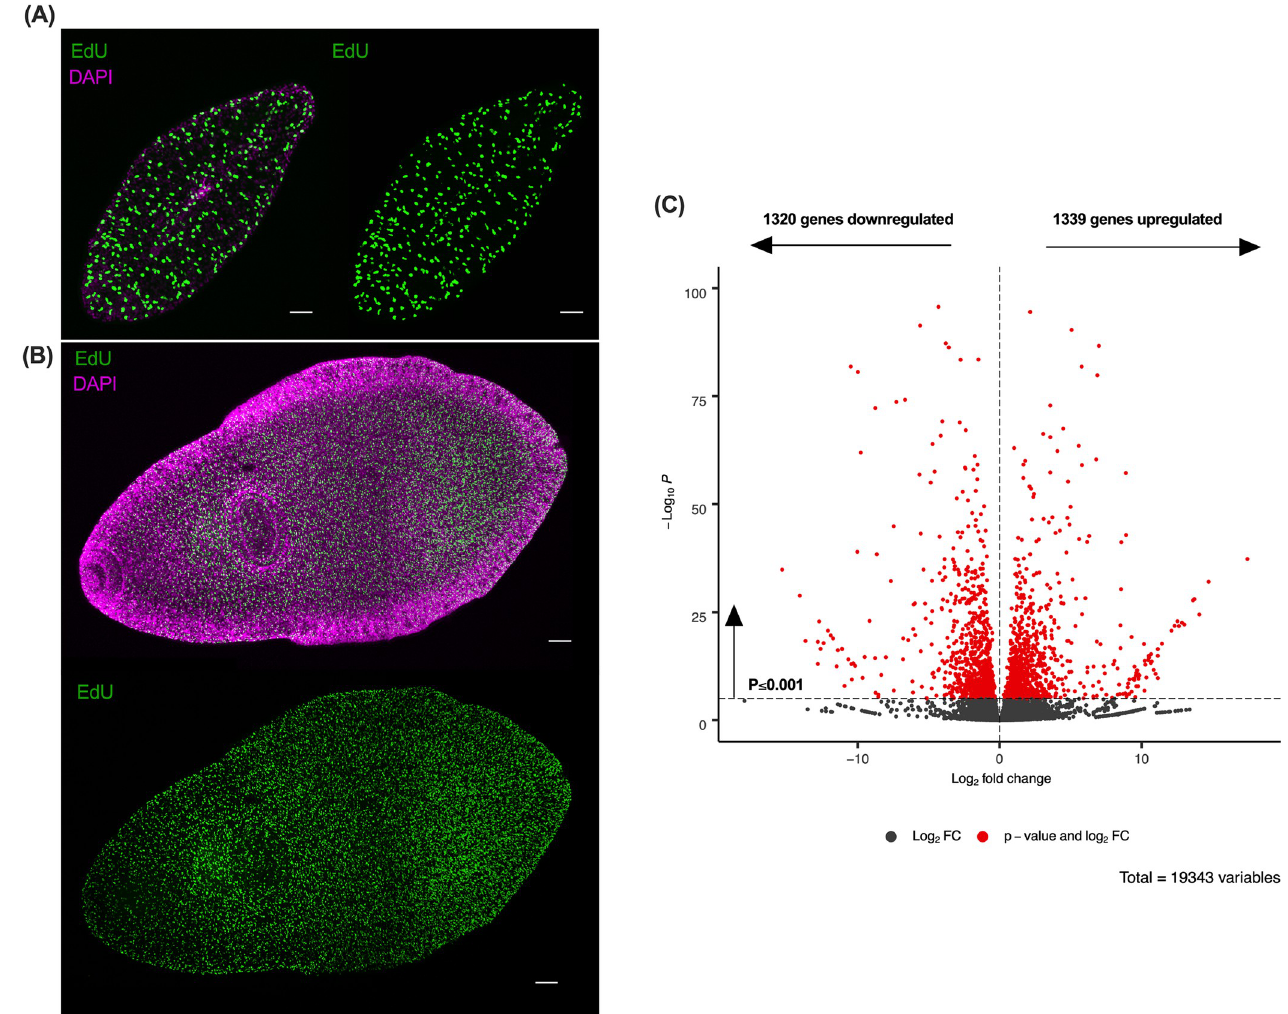
Fig 2. In vitro and in vivo maintained juvenile liver fluke display differences in growth and cell proliferation. (A) Cell proliferation represented by EdU + cells (green) of 21 day old (+1 day labelling) in vitro maintained juvenile Fasciola hepatica . (B) Cell proliferation represented by EdU+ cells (green) of 21 day old (+1 day labelling) in vivo maintained juvenile F . hepatica . Confocal Z stack images; green = EdU+; magenta = DAPI; in vitro scale bar = 50 μ m; in vivo scale bar = 100 μ m. (C) Volcano plot of differentially expressed transcripts between in vitro and in vivo maintained juveniles . Analysis identified 1339 transcripts upregulated and 1320 transcripts downregulated in vivo compared to in vitro maintained juveniles with a false discovery rate (FDR) of P � 0.001. Red = significantly differentially expressed genes. Grey = not differentially expressed